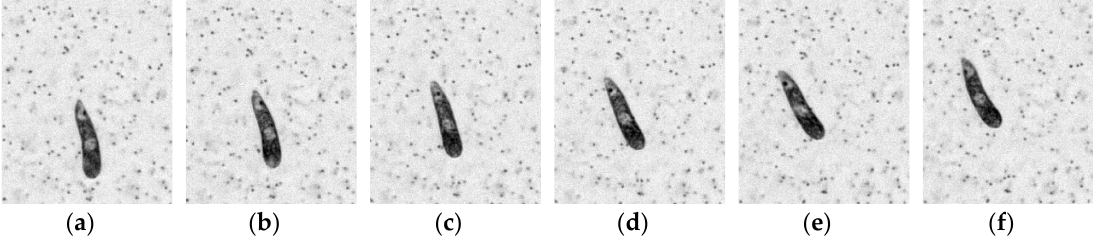
Figure 12. Rolling motion of a 48µm-tall Euglena gracilis at various time steps. ( a ) t = 2 s ( b ) t = 2.16 s ( c ) t = 2.32 s ( d ) t = 2.48 s ( e ) t = 2.64 s ( f ) t = 2.8 s.